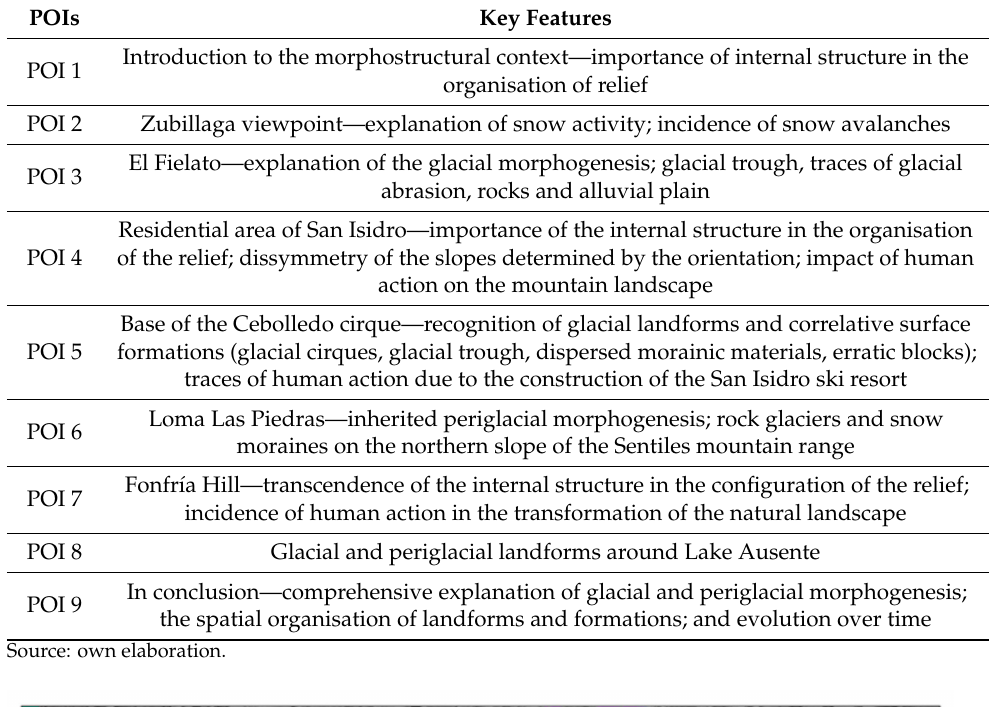
Table 2. Points Of Interest (POIs) in the itinerary and key features to be observed.